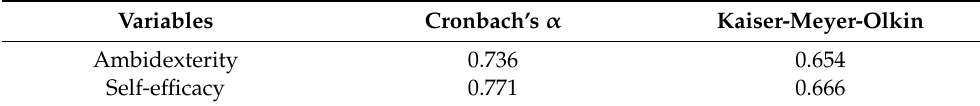
Table 2. Results of validity and reliability assessment.